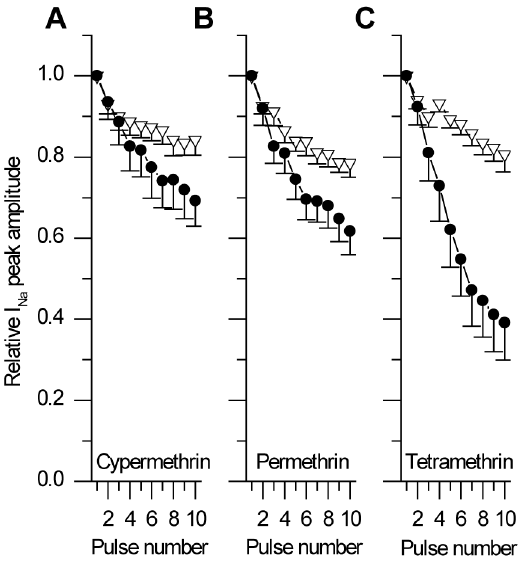
Figure 4. Effect of pyrethroids on the use-dependent decrease in the sodium current peak. Mean evolution of the relative amplitude of the peak current along with protocol shown in Figure 2 (current normalized to the amplitude obtained at the first pulse of the train) from ALNs in a control solution (empty triangles) and after exposure to pyrethroids (filled circles). All pyrethroids tested amplify the decrease in current amplitude and tetramethrin (n=10) has a stronger effect than cypermethrin (n=6) or permethrin (n=10).